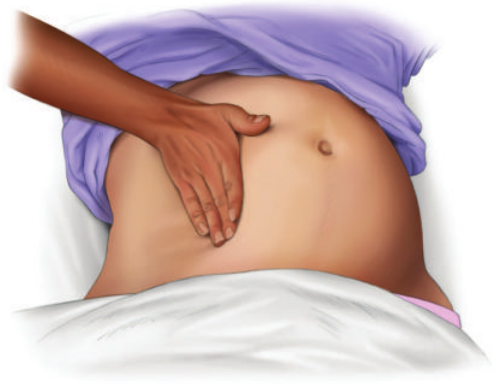
Figure 3: Left uterine displacement using 1-handed technique [3].